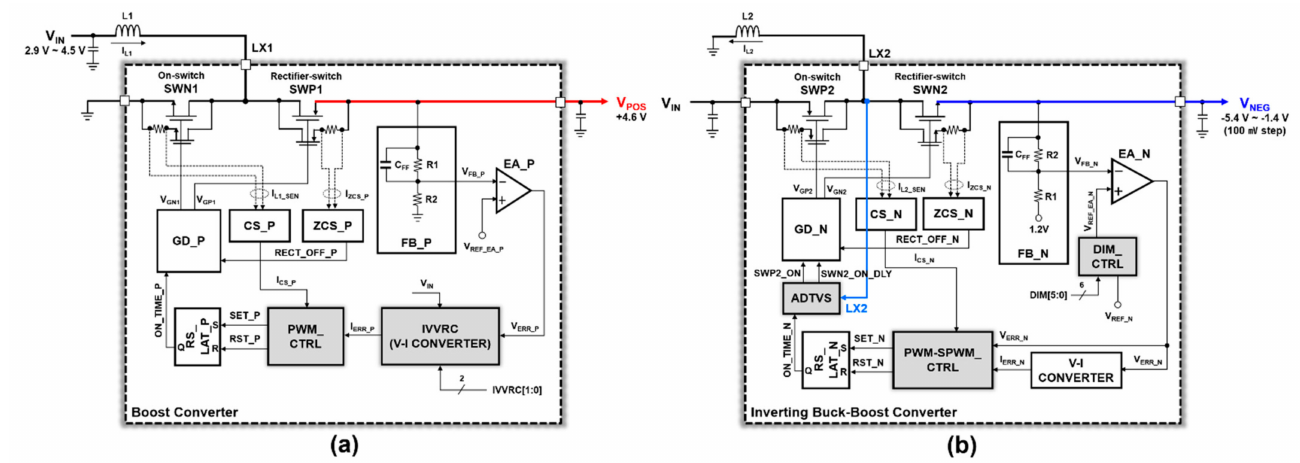
Figure 1. Block diagram of the proposed two-channel high-performance DC-DC converter for mobile AMOLED displays: ( a ) V POS ; ( b ) V NEG